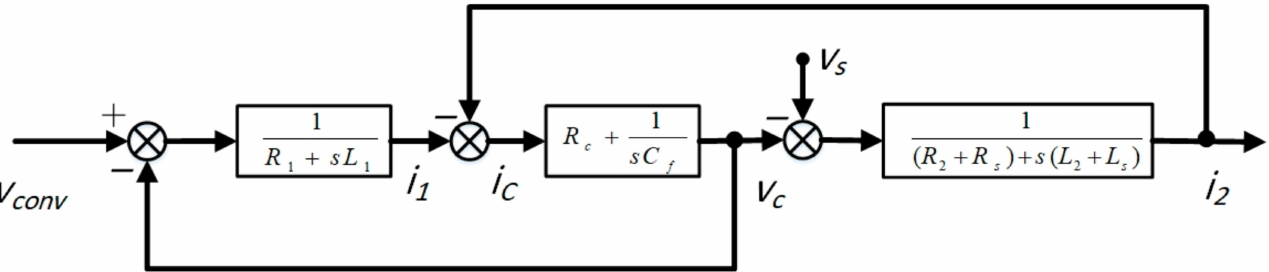
Figure 6. Laplace domain model of a grid converter with an LCL